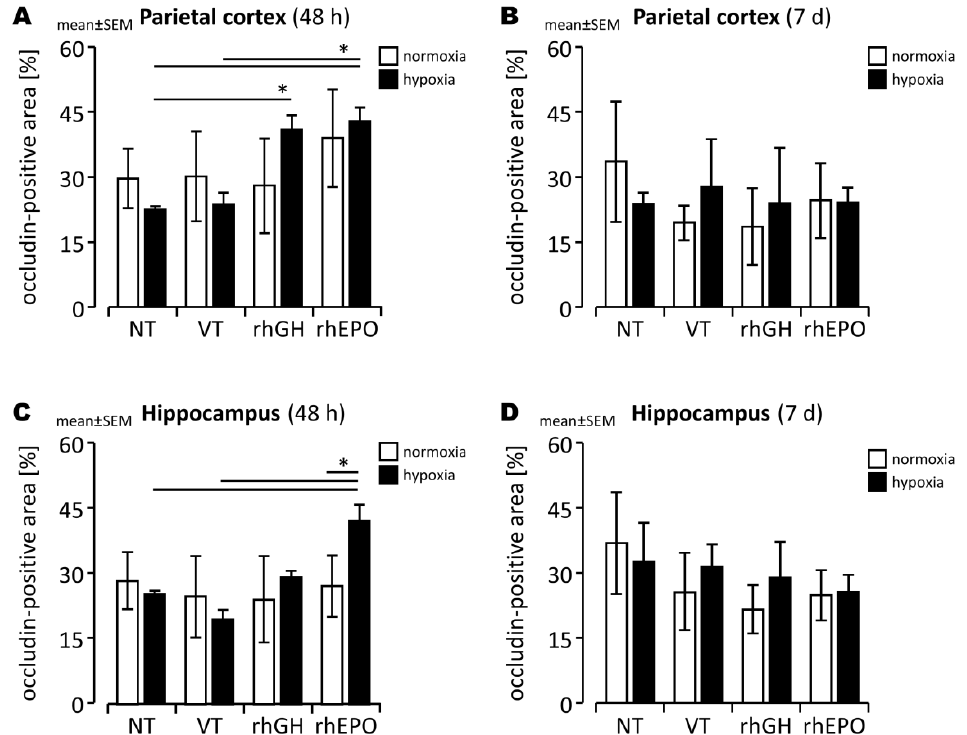
Figure 4. Quantification of OCLN + area by immunofluorescence analysis of OCLN and PECAM-1 protein in normoxic and hypoxic developing mouse brains with and without rhGH and rhEPO treatment after a regeneration period of 48 h ( A , C ) and 7 d ( B , D ) in the parietal cortex ( A , B ) and hippocampus ( C , D ). Data are presented as mean ± SEM. *, p < 0.05.